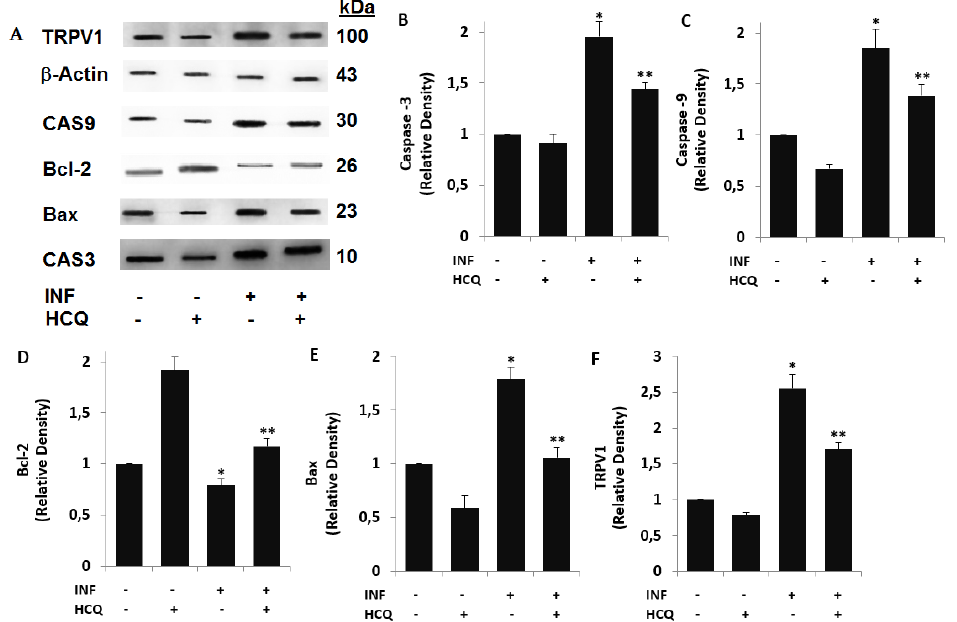
Figure 2. Acute inflammation (INF)-induced increases of TRPV1 and apoptotic factors were modulated by the HCQ treatment (60 µ M). (Mean ± SD and n = 3). ( A ) The imaging total protein expression bands of Western blot. ( B – F ) indicate the mean expression concentrations of caspase -3 (CAS3), caspase -9 (CAS9), Bcl-2, Bax, and TRPV1 in the U937 monocytes, respectively. (* p < 0.05 vs. Cntr and HCQ. ** p < 0.05 vs. INF). The significance of p -values was analyzed by using the test of